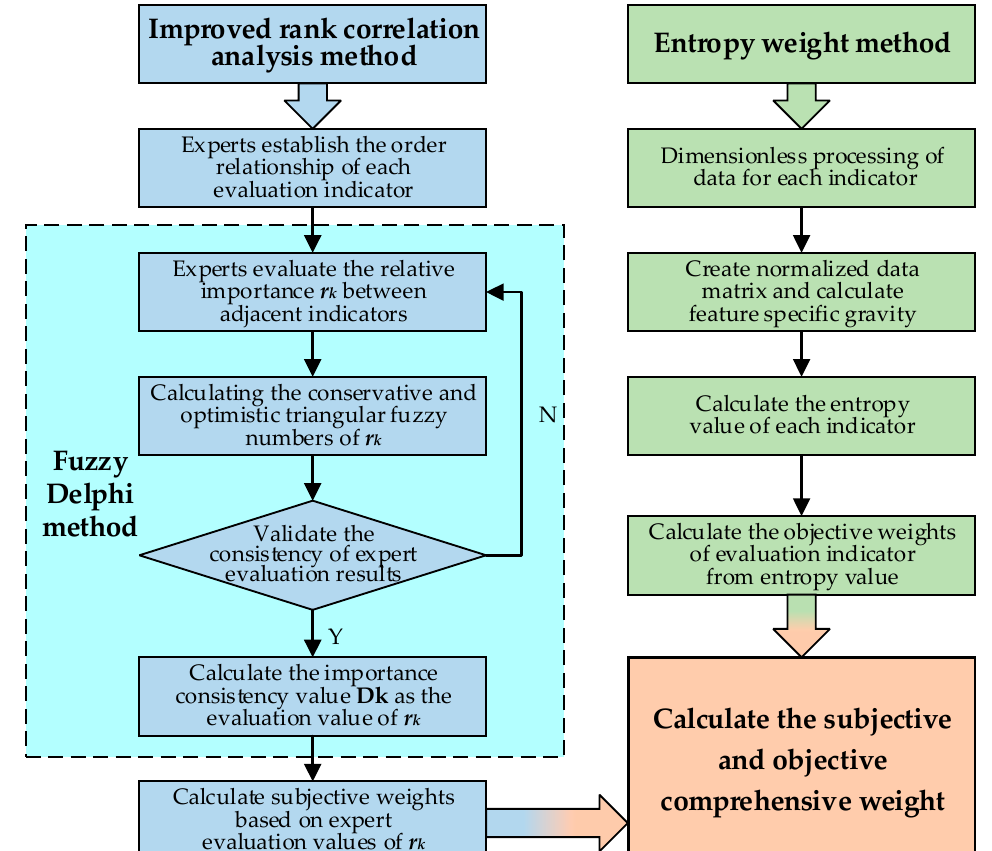
Figure 1. Subjective and objective combination weighting method flow.